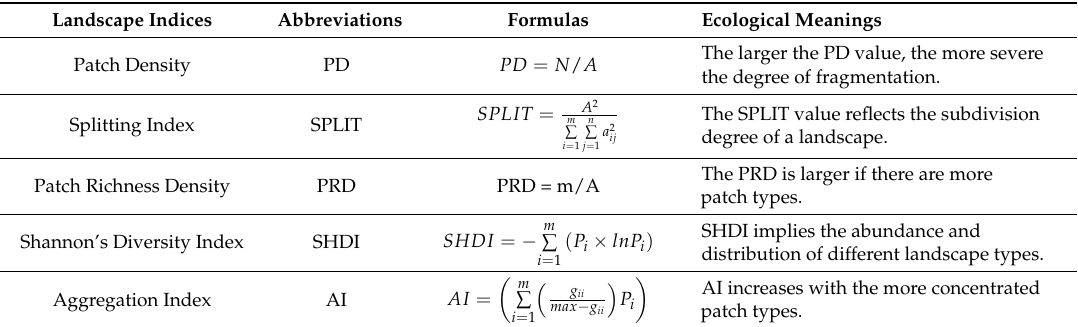
Table 1. Selected landscape indices and their ecological